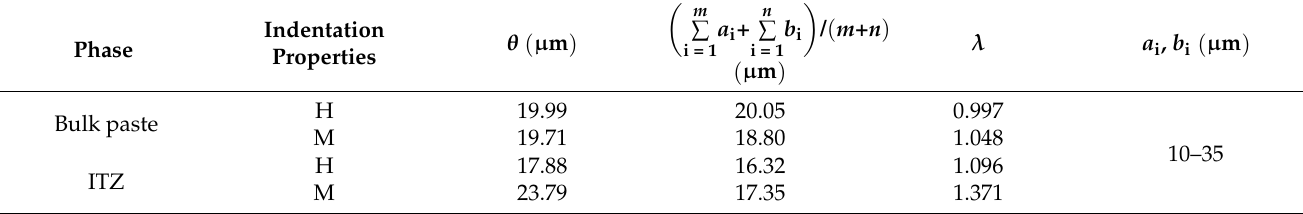
Table 6. The values of factors in Equation